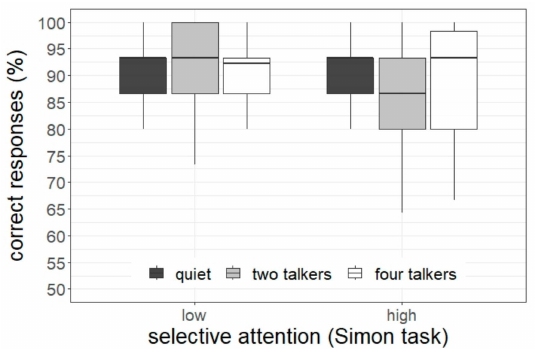
Figure 3. Task accuracy as a function of students’ selective attention (as assessed by the Simon task) and listening